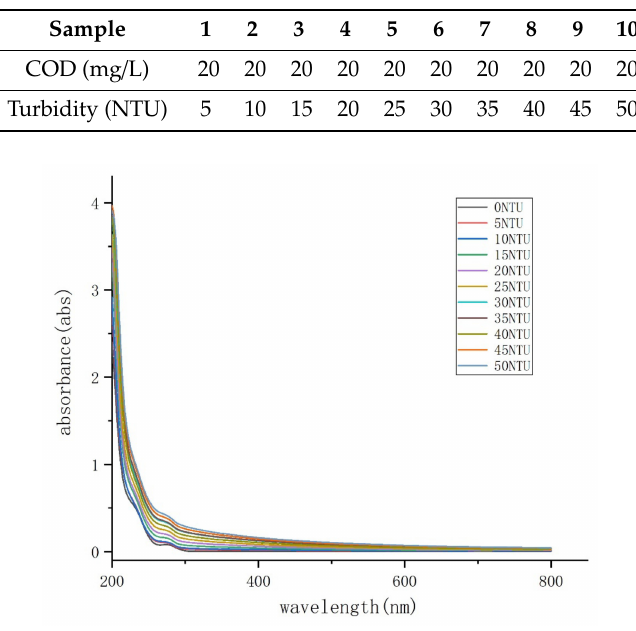
Figure 14. Original UV–Vis absorption spectra of solutions with di ff erent